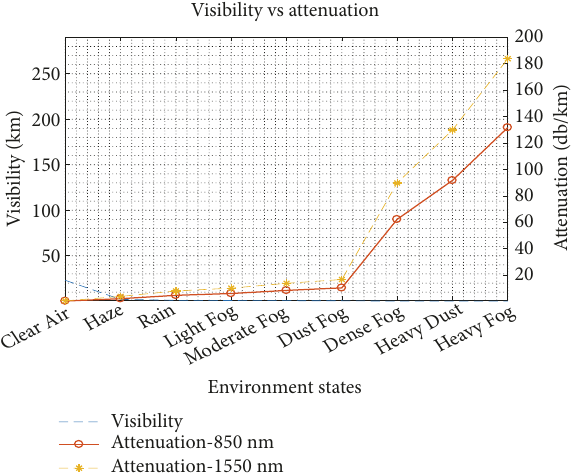
Figure 7: The attenuation (db/km) and visibility (m) at different wavelengths